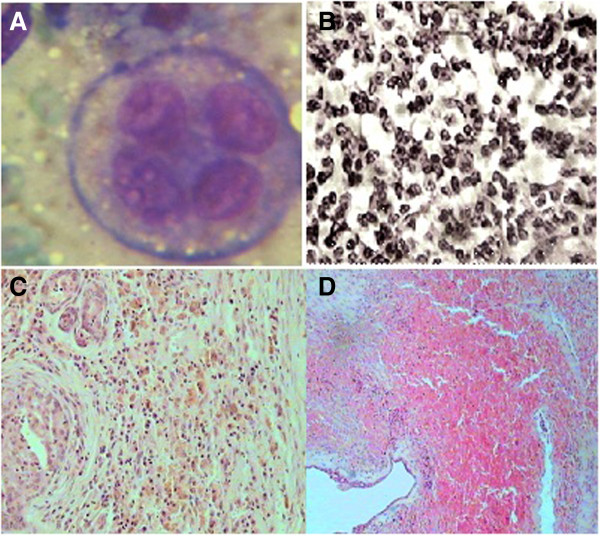
Evaluation of accuracy of fine needle aspiration cytology and histopathology for diagnosis of feline mammary tumours. A: Malignant multinucleated mammary epithelial cell; nuclei exhibit nuclear criteria of malignancy; nuclei super imposed and in different focal planes. May-Grunwald-Giemsa staining method, 1000X. B: Cells exhibit variable numbers of mitoses are found; or the second populationof cells may have oval to fusiform vesicular nuclei with an extensive amount of eosinophilic cytoplasm and distinc cell margins (H&E, X 400). C: Solid adenocarcinoma; The presence of neoplastic, mitotic and inflammatory cells (H&B, X 200.), D: Hemorrhage foci and the central necrotic areas are interpreted as an indication that the neoplastic cells are growing faster and that there is therefore a higher risk of progressionto invasive carcinoma (H&E, X100).